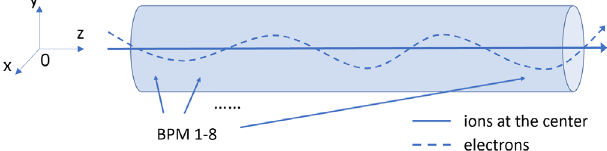
FIG. 3. The simulation considers a real-world scenario where electrons travel through the cooling sections and are monitored by 8 BPMs.